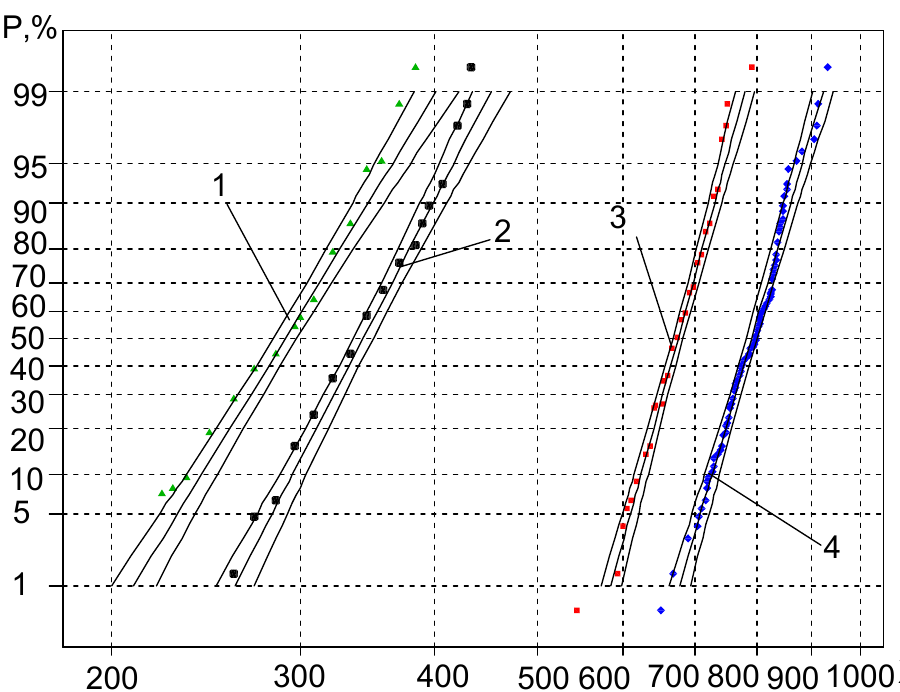
Figure 10. Statistical distribution curves for the mechanical properties of steel C45 without adjusting for the sensitivity thresholds 𝑁 (cid:2868) and 𝑁 (cid:3038) (1— 𝜎 (cid:3052) , 2— 𝜎 (cid:3043)(cid:3045) , 3— 𝜎 (cid:3048) , 4— 𝑆 (cid:3038) ).